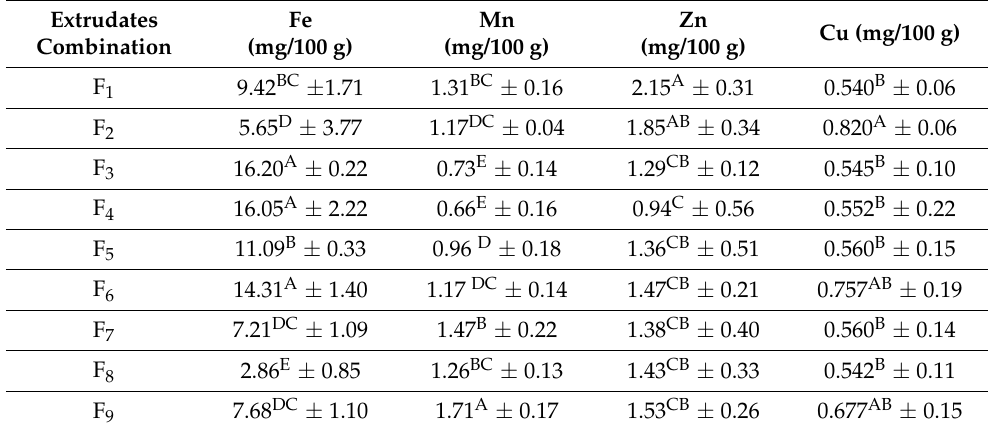
Table 12. Trace mineral composition of neera honey incorporated